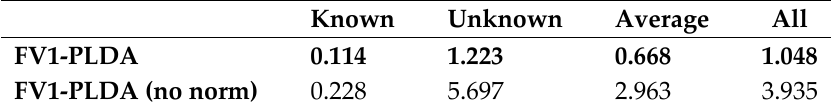
Table 2. Comparison of spoofing detection performance (in terms of EER) of the Fisher vector-based systems with power normalization followed by L 2 normalization (FV1-PLDA) and without any normalization (FV1-PLDA (no norm)). The best results are highlighted in bold face.